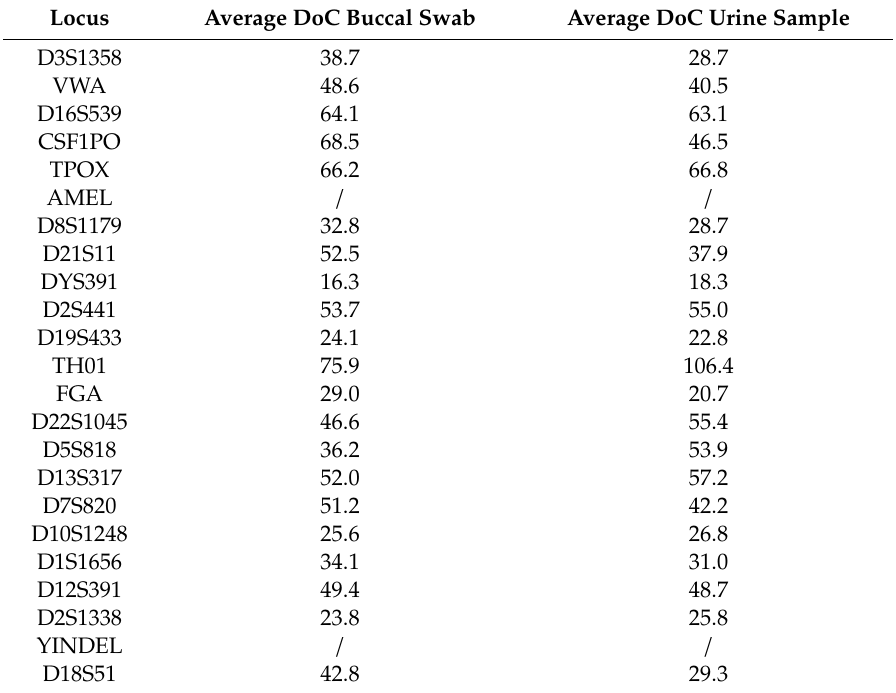
Table 1. Overview of the average DoC for each of the 23 loci regarding buccal swab and urine samples. DoC: Depth of